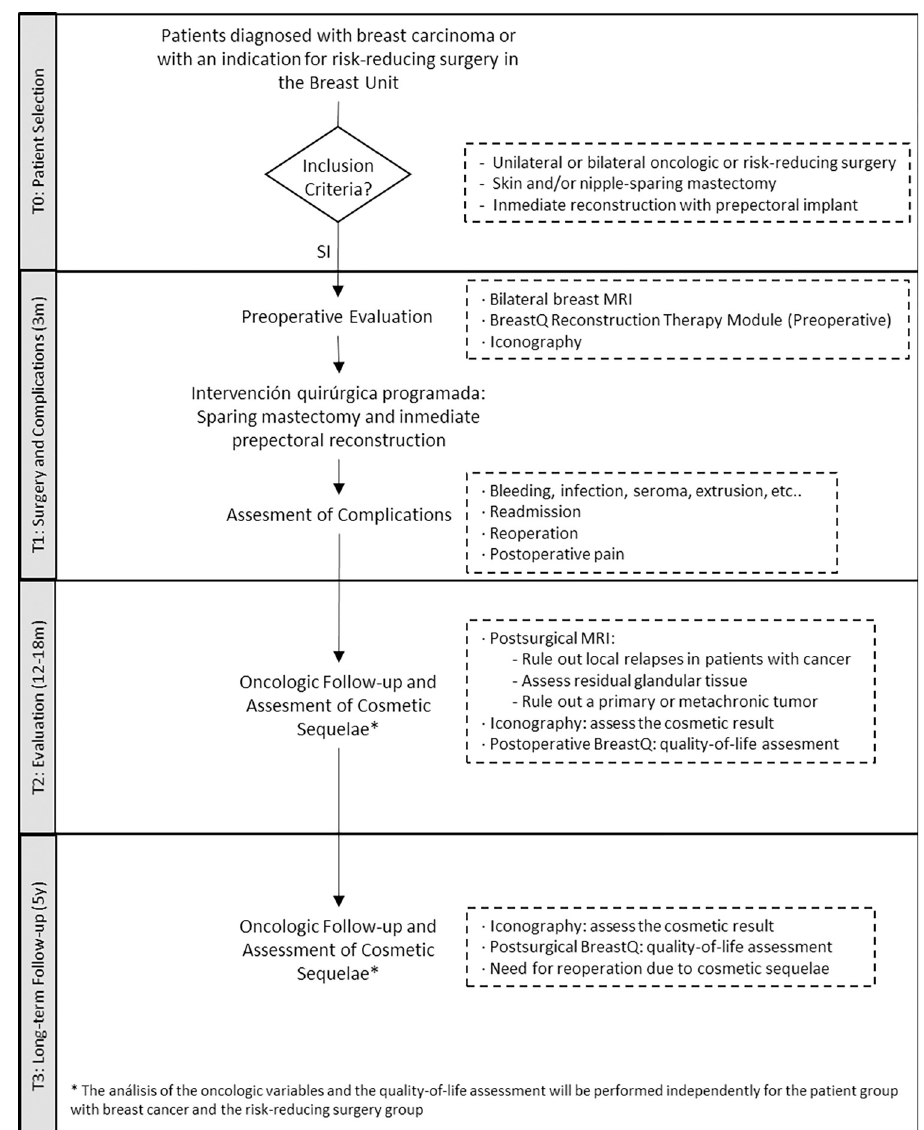
Fig 1. Methodology algorithm for the PreQ-20